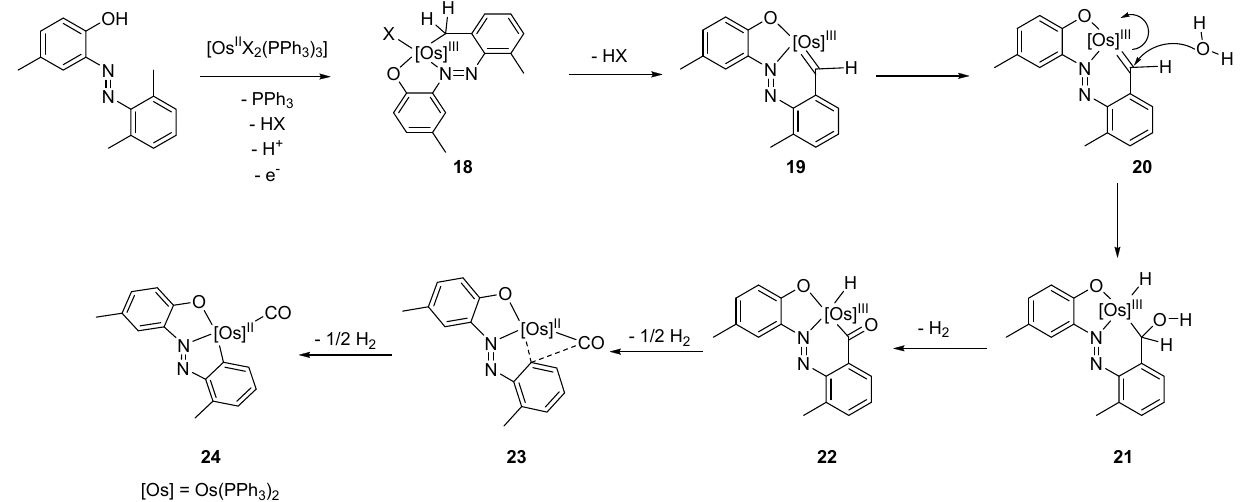
Figure 5. Synthesis of C~N~O pincer complexes.